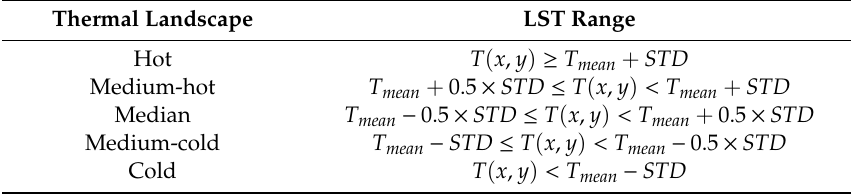
Table 3. Thermal landscape classification using mean-standard deviation (STD)